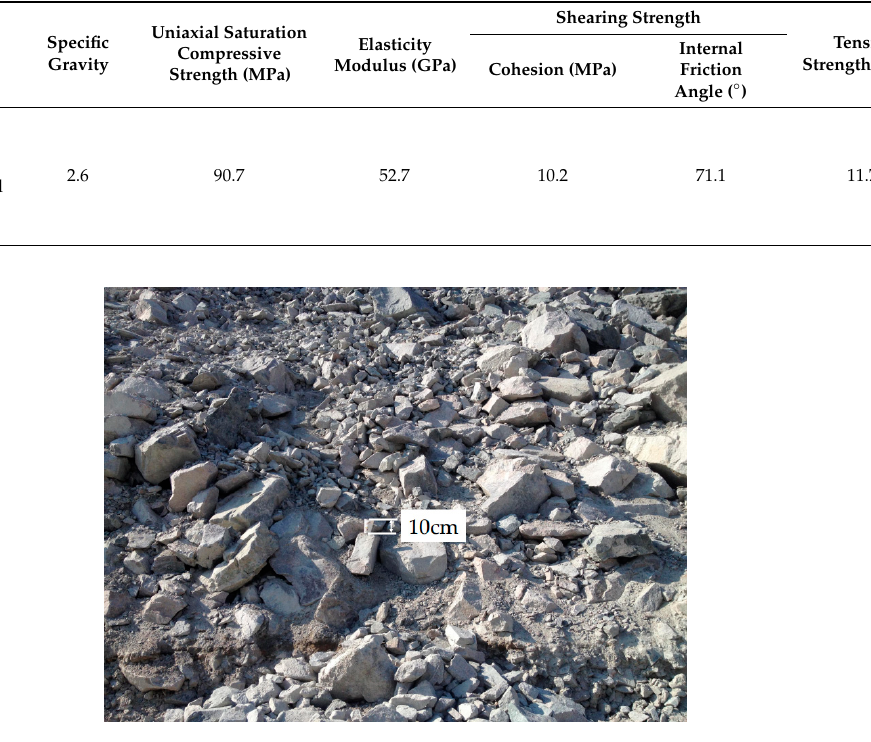
Figure 1. Overview of the rockfill. The horizontal boundary width of the red curve is about 100 m, and the maximum vertical level difference is about 50 m. Table 1. Physical and mechanical properties of intact rocks (from geological survey report).